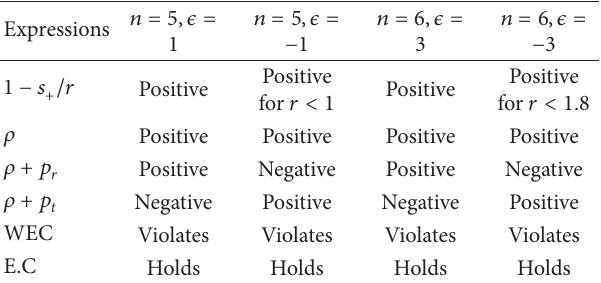
Table 1: Wormhole solutions with Gaussian distributed noncom- mutative framework for 𝑠 +